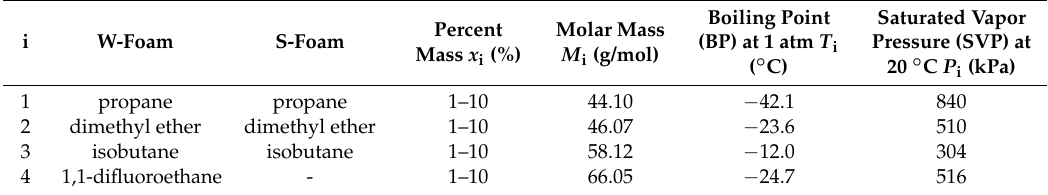
Gas mixture chemical composition and physical properties of the components.